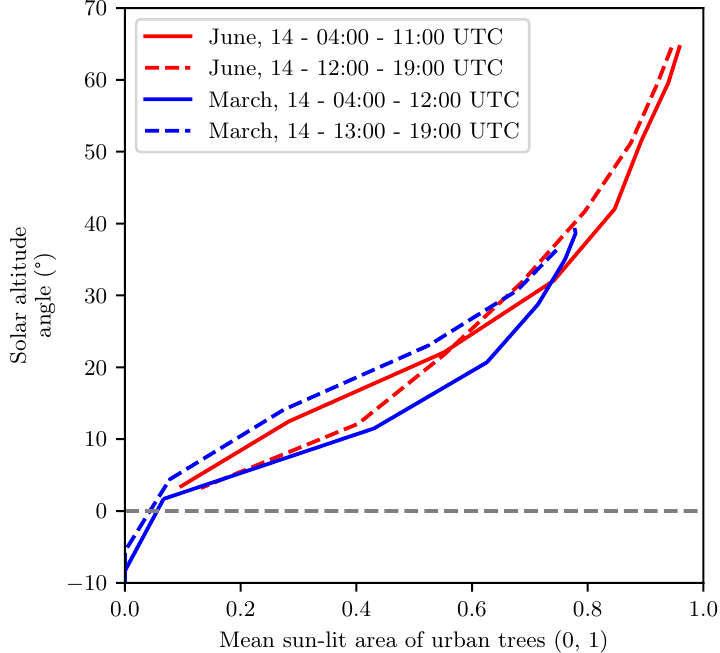
Figure 7. Relationship between sunlit area of urban trees and the solar altitude angle under clear sky conditions. Solar altitude angle and sunlit area of urban trees show strong correlation. The figure shows the relationship for a the 14th of March and the 14th of June, divided into rising sun (solid) and setting sun (dashed). The sun lit area is the mean sunlit area on hourly basis, based on all urban trees in the urban district Rieselfeld in Freiburg,